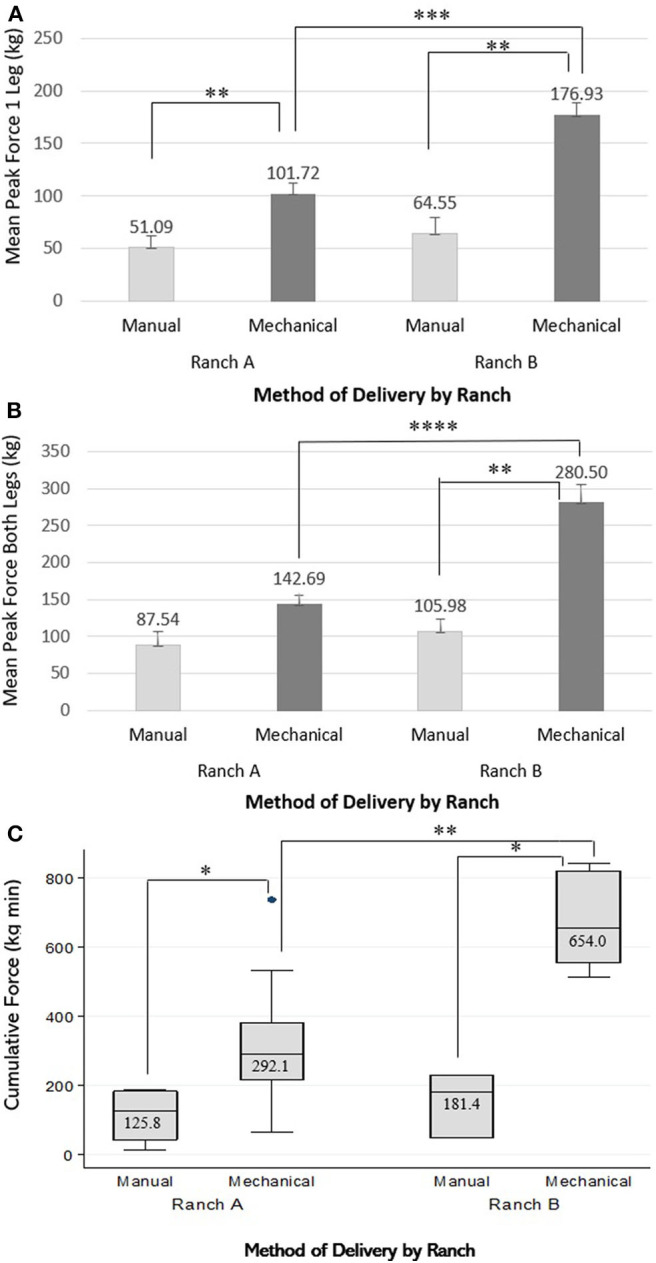
Visual description of the effect of an interaction between method of delivery (Manual or Mechanical) and ranch (Ranch A or Ranch B) on (A) mean peak force on one leg (kg), (B) mean peak force on both legs (kg), and (C) cumulative force (kg min) for assisted delivery of 25 beef calves on 2 ranches. *P ≤ 0.05, **P ≤ 0.01, ***P ≤ 0.001, ****P ≤ 0.0001. The number of calves manually delivered on Ranch A was 4 and on Ranch B was 3, and the number of calves mechanically delivered on Ranch A was 12 and on Ranch B was 6.